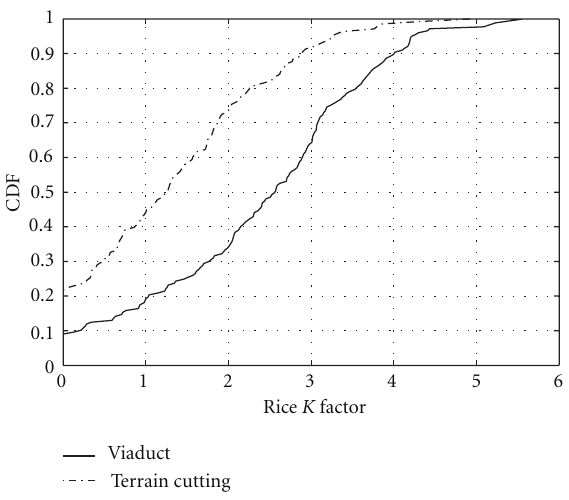
Figure 5: CDF of the K factors in both scenarios.